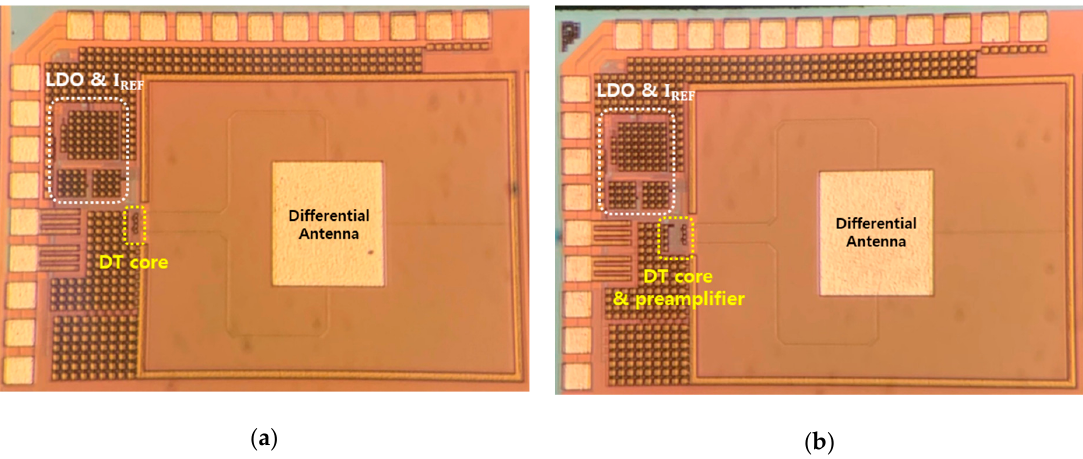
Figure 5. Photographs of the fabricated complementary metal-oxide-semiconductor (CMOS) plasmon detector integrated circuits: ( a ) Differential detector including the integrated antenna and the bias circuits; ( b ) Detector including the integrated antenna, the bias circuits, and the subthreshold preamplifiers.